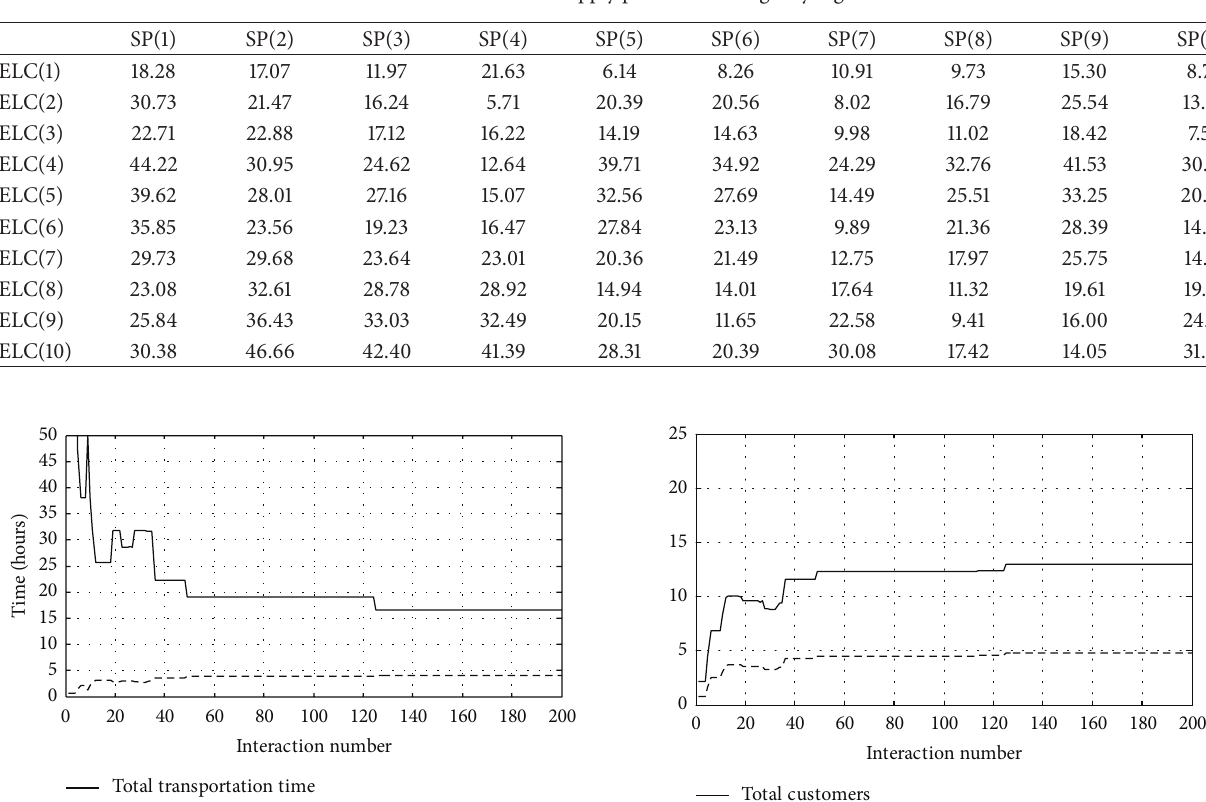
Table 3: The distance between supply point and emergency logistics center.